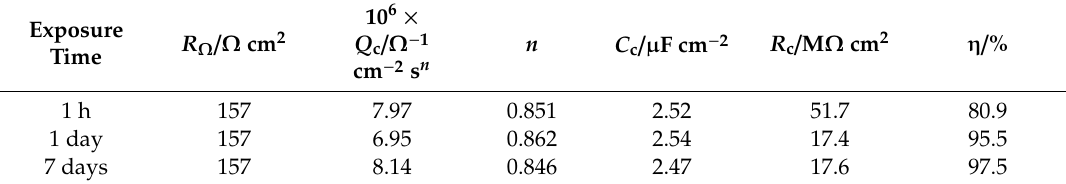
Table 3. Impedance parameters and protection e ff ectiveness values calculated for EIS data of the Ti-implant / oxide film / D3 layer / artificial saliva interface (Figure 5b) recorded at E OC after various exposure times